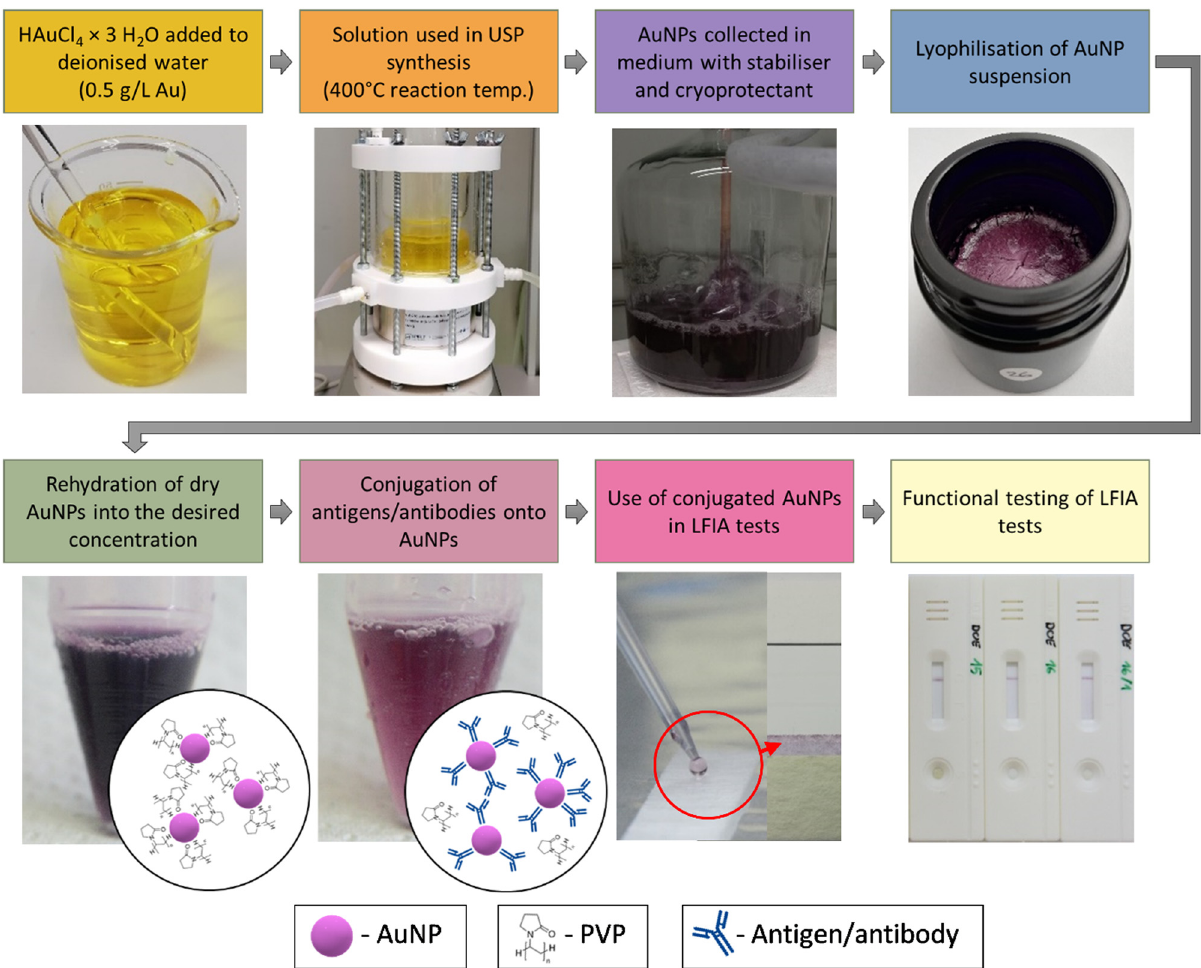
Figure 1: Preparation fl ow chart of the LFIA tests with key steps from the synthesis of AuNPs with USP, collection of AuNPs and their stabilisation in suspension, lyophilisation of the AuNPs ’ suspension, rehydration of dry AuNPs into the desired concentration, and con - jugation of antigens/antibodies to the fi nal assembly of the prototype LFIA tests with functional